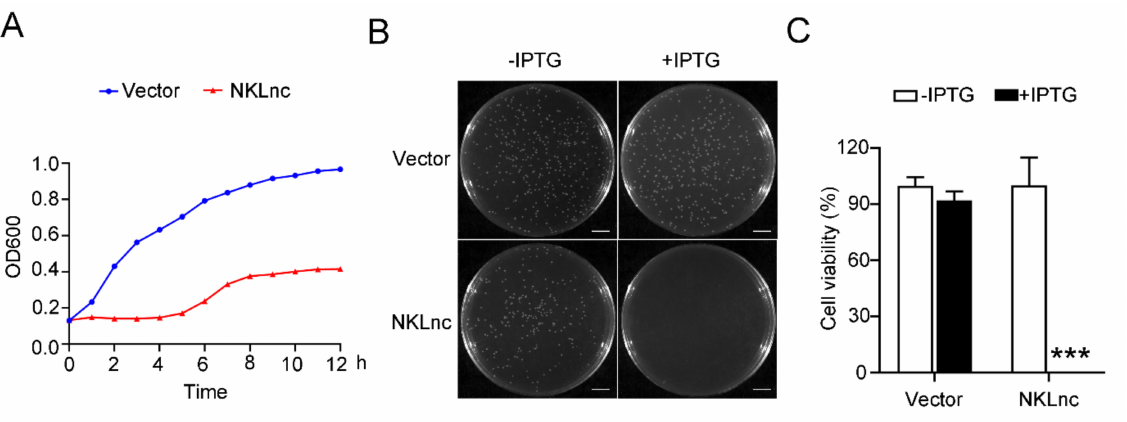
Figure 3. The effect of NKLnc expression on host bacterial growth. ( A ) Escherichia coli was transformed with the backbone vector or the vector carrying the NKLnc gene inducible by IPTG. The bacteria were cultured in the presence of IPTG and determined for growth at different hours. ( B , C ) The above E. coli cells were plated in an agar plate supplemented with or without IPTG, and bacterial growth was observed after overnight incubation. Scale bar, 1 cm ( B ). The percentages of bacterial survival were determined ( C ). Values are the means of triplicate assays and shown as means ± S.D. *** p < 0.001. 2.4. A NKLnc-Derived Peptide Is Bactericidal in a Manner That Depends on Two Alpha